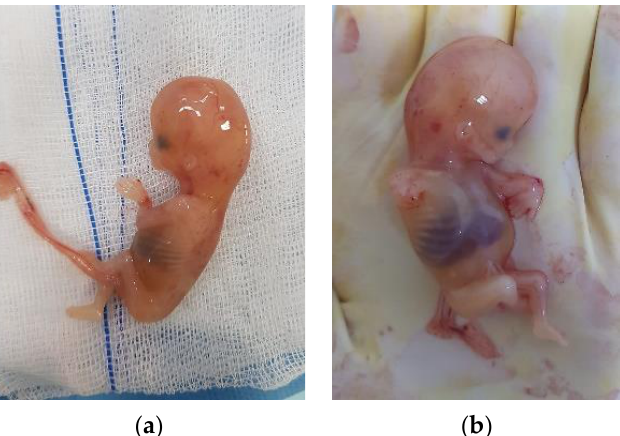
Figure 6. Intra-operative image after left salpingectomy.